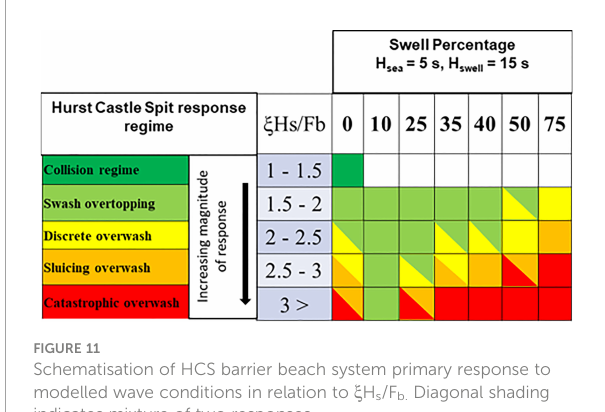
FIGURE 11 Schematisation of HCS barrier beach system primary response to modelled wave conditions in relation to x H s /F b. Diagonal shading indicates mixture of two responses.